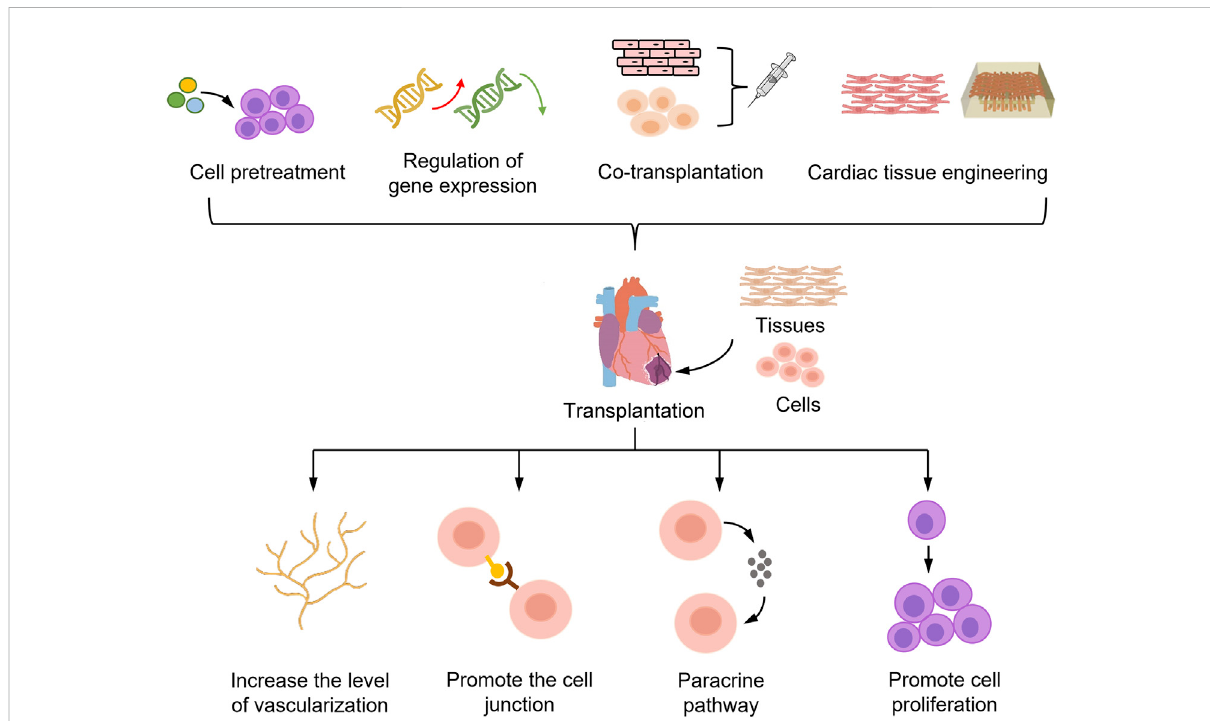
FIGURE 1 Strategies to enhance the ef fi cacy of PSC-CMs in the treatment of myocardial infarction. PSC-CMs transplanted into the myocardial infarct region die in large numbers during the initial stage of transplantation, limiting the potential of PSC-CMs for cell therapy. To improve the survival rate of PSC-CMs, the main strategies adopted are pretreatment of PSC-CMs, gene expression modulation, co-transplantation with other cells, and cardiac tissue engineering. These strategies mainly aim to increase the number of cells and survival of PSC-CMs after transplantation